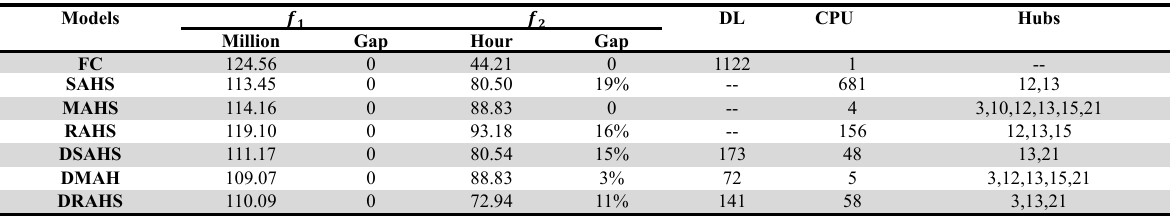
The optimal solution for each model Models